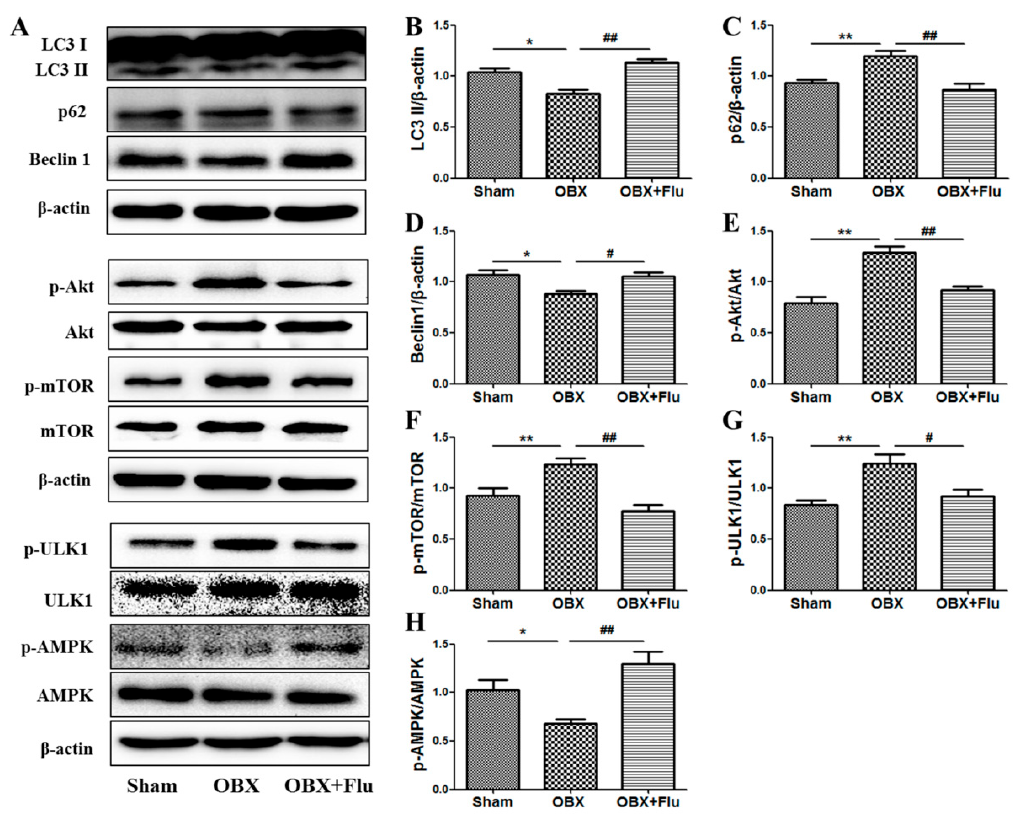
Figure 7. Effects of OBX and fluoxetine treatment on the expression of proteins associated with autophagy in the hippocampus of rats. ( A ) Representative protein bands. ( B – H ) The relative grey values of LC3 II/ β -actin, p62/ β -actin, beclin1/ β -actin, p-Akt/Akt, p-mTOR/mTOR, p-ULK1/ULK1, and p-AMPK/AMPK. * p < 0.05, ** p < 0.01 compared to the sham group. # p < 0.05, ## p < 0.01 compared to the OBX group (mean ± SEM, n = 4). Flu, fluoxetine. OBX, olfactory bulbectomy.